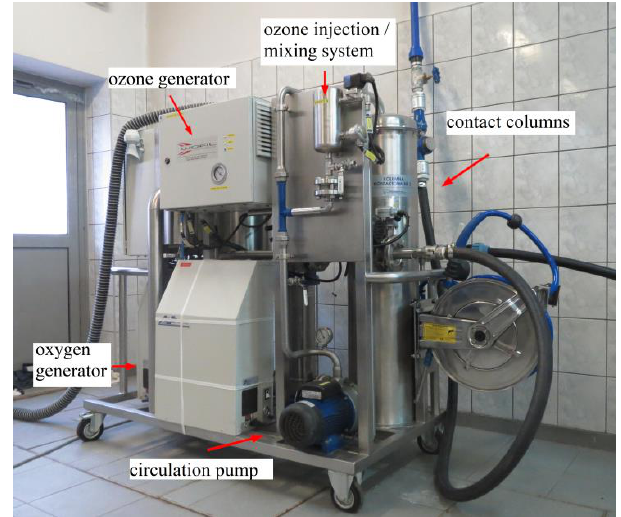
Figure 2. Mobile ozonation system.